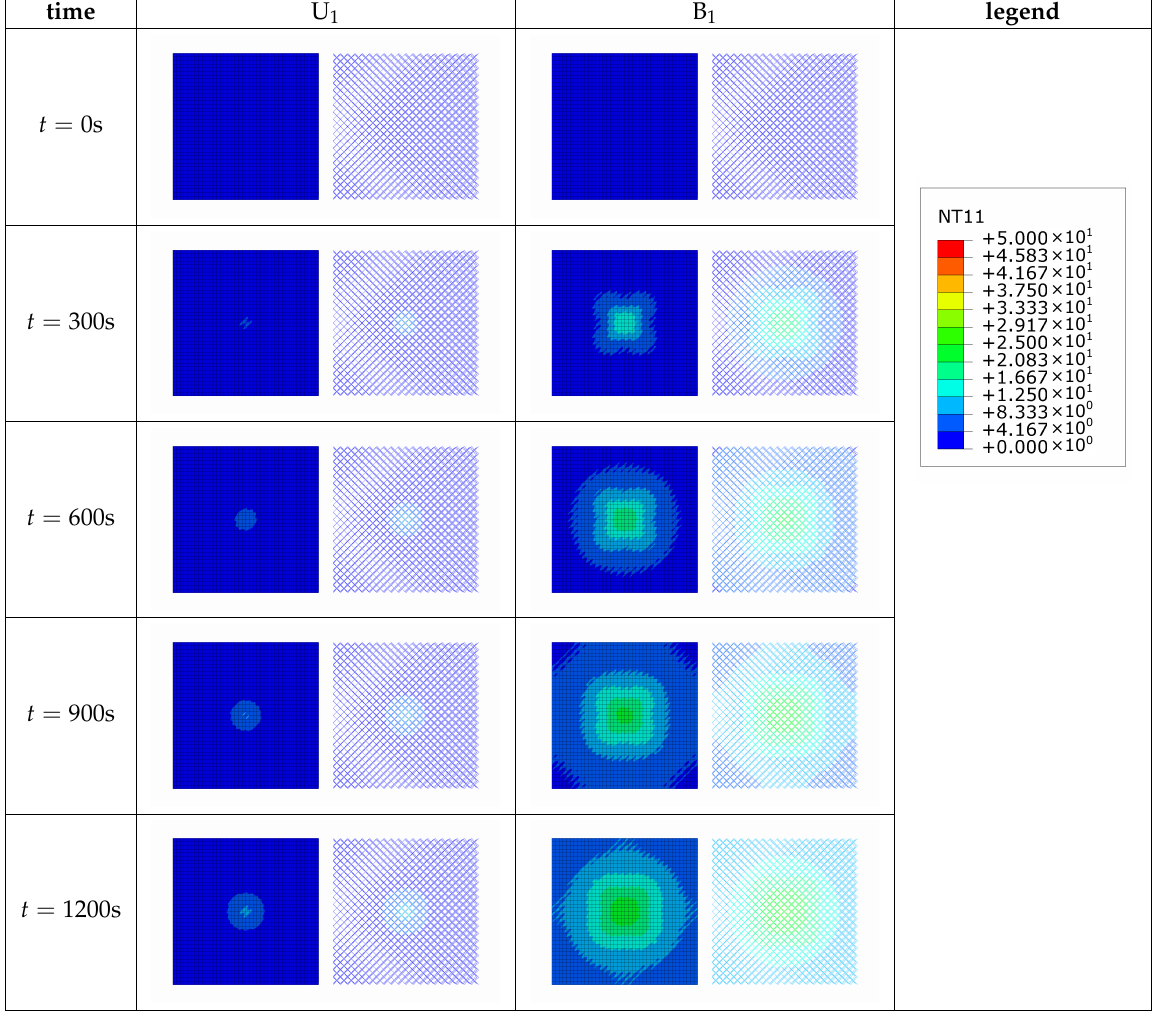
Figure 13. Transient heat transfer process analysis results of U 1 and B 1 under WC 2 . Table 3. The value of ∆ T ave and Q c of both designs under 2 working conditions.